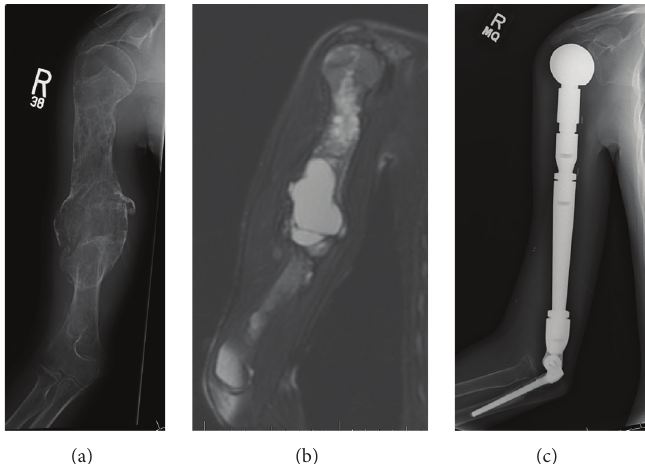
Figure 1: 16-year-old male with telangiectatic osteosarcoma of the humeral shaft, treated with total humeral resection and endoprosthetic